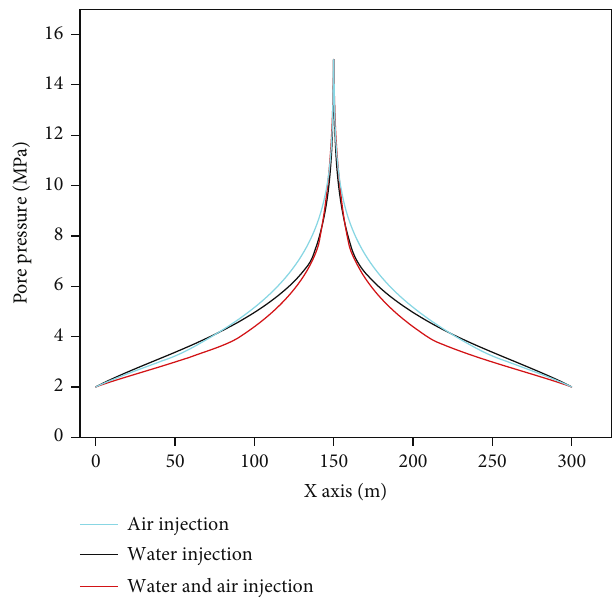
Figure 16: Pore pressures under three displacement methods at 24h along line L.